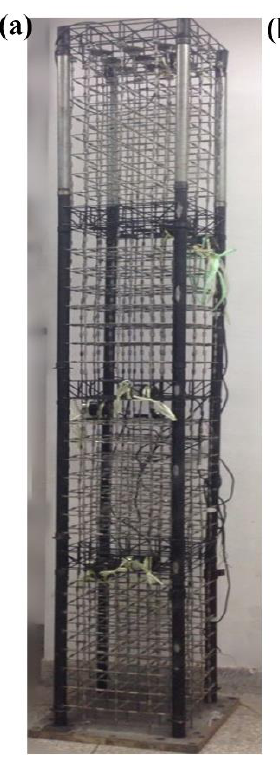
Figure 5. The investigated best candidate MSCSS0001 configuration together with the sensor arrangement. ( a ) The fabricated steel frame of the investigated best candidate configuration MSCSS0001 in the ratio of 1:100; ( b – d ) The front view, the side view and the top view of the schematic diagram together with the arrangements of sensors, respectively. These numbers from 1 to 32 highlight the labeled tags/identifiers of utilized sensors in different position. Table 10. The comparations of the theoretical and experimental frequencies (Hz) together with their error bar.